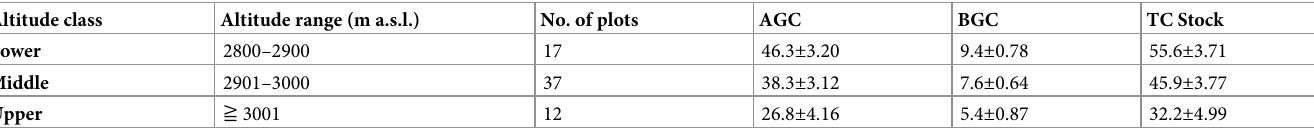
Table 4. Mean TC stocks (Mg ha − 1 ) in above- and belowground C pools along three altitudinal gradients. Altitude class Altitude range (m a.s.l.) No. of plots AGC BGC Lower 2800–2900 17 Middle 2901–3000 Upper ≧ 3001 32.2 ± 4.99 AGC = Aboveground carbon, BGC = Belowground carbon, and TC = Total carbon.